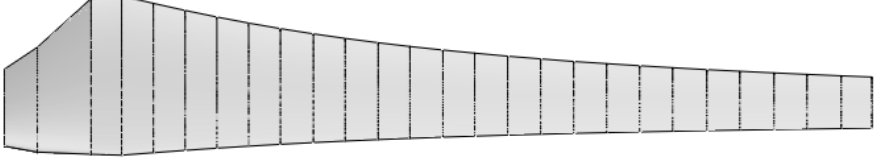
Figure 5. FX blade geometry in the QBlade design module, front view.